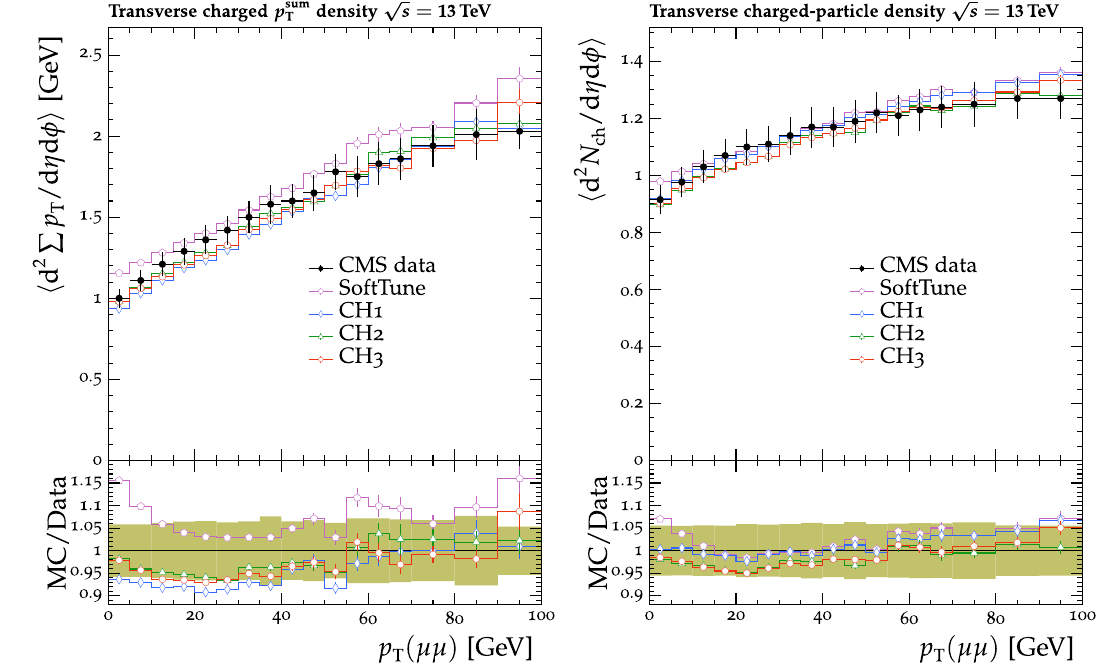
Fig. 16 The p sum from MadGraph 5_a mc@nlo + herwig 7, with the SoftTune and CH (left) and N ch (right) density distributions in the T tunes. The coloured band in the ratio plot represents the total experi- transverse region, as a function of the p T of the two muons, p T (μμ) mental uncertainty in the data. The vertical bars on the points for the [45]. The transverse region is defined with respect to p T (μμ) , where different predictions represent the statistical the two muons are required to have an invariant mass close the the mass of the Zboson. CMS Zboson data are compared with the predictions